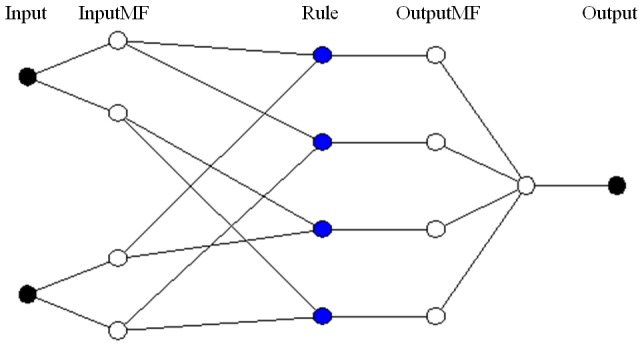
ANFIS structure with two inputs for wind turbine noise assessment.